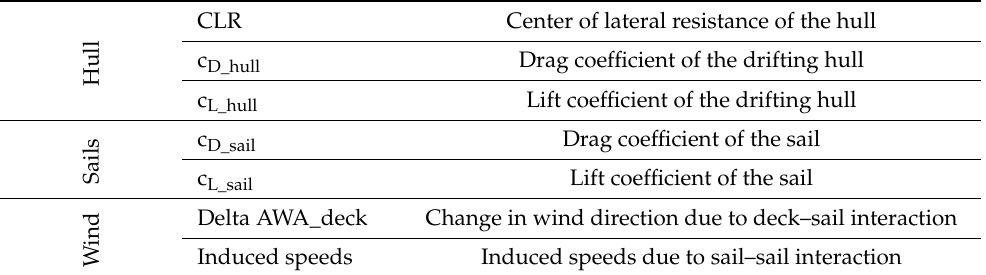
Table 2. Parameters for the performance prediction of